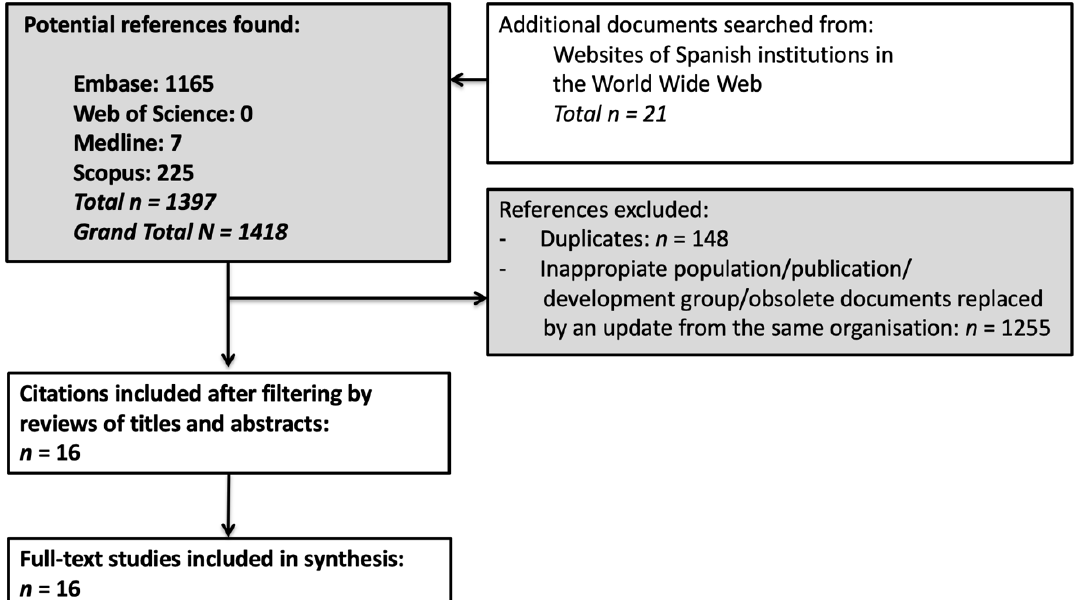
Figure 1. Flow chart of the literature search.